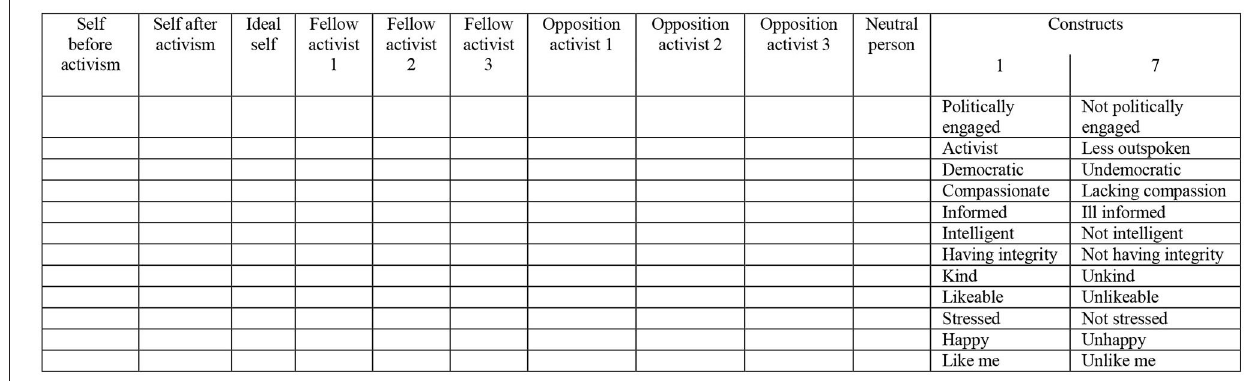
FIGURE 1 | Repertory grid (adapted from Winter,